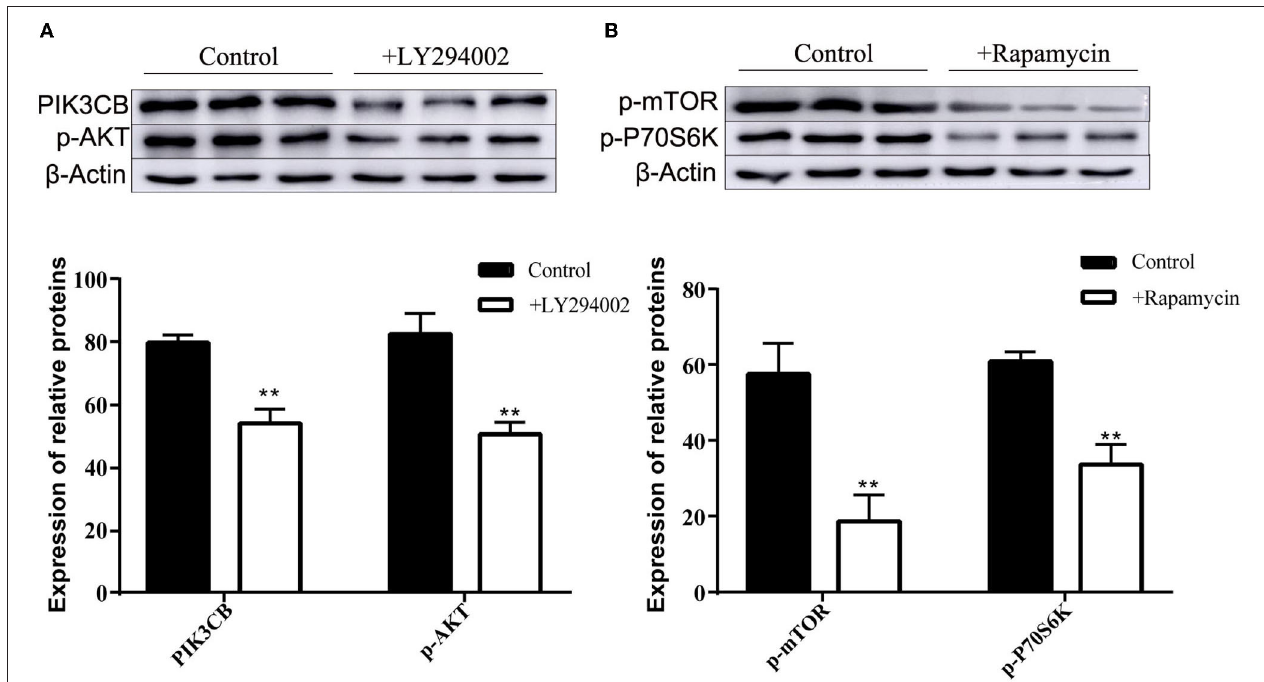
FIGURE 11 | Protein expression with adding inhibitor LY294002 (A) and Rapamycin (B) in tissue culture ( n = 9). One-way ANOVA in SPSS 22.0 software was used to analyze the data, presented as mean ± sd. The ratio of all gene expression levels compared to the housekeeping gene β -actin was obtained as the relative expression of the gene. **Indicates highly significant difference ( p <